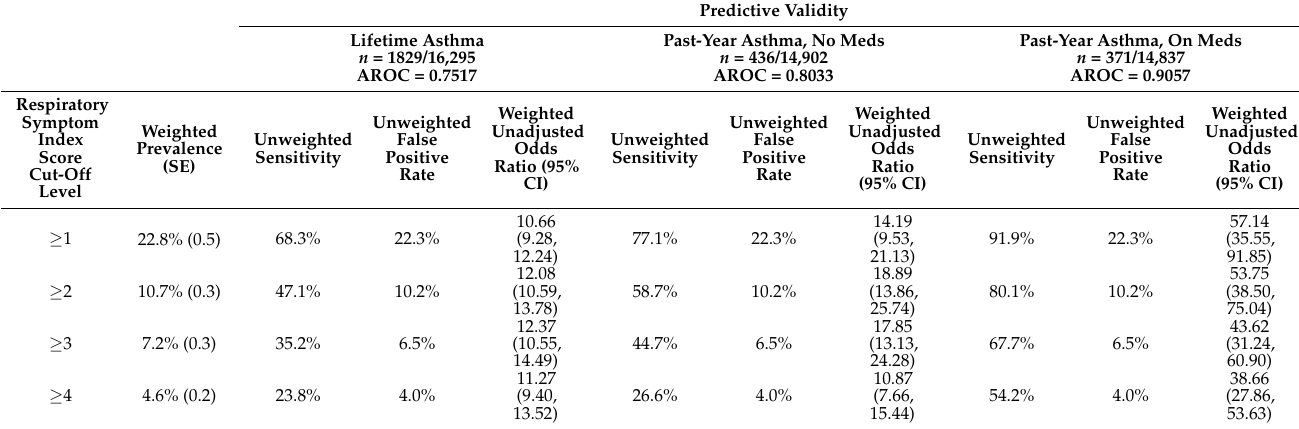
Table 2. Association between four respiratory symptom score cut-off levels and self-reported asthma diagnosis, Wave 2 (2014–2015) PATH